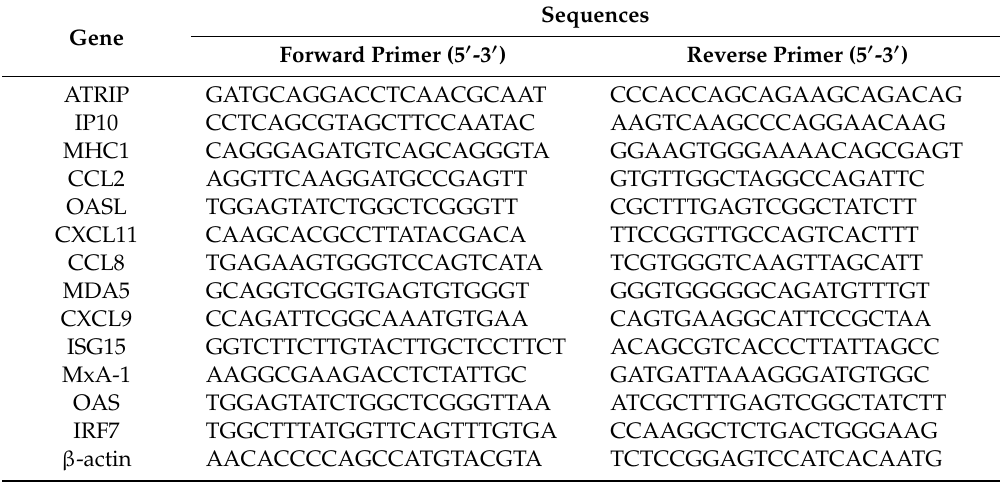
Table 1. Primers for the selected